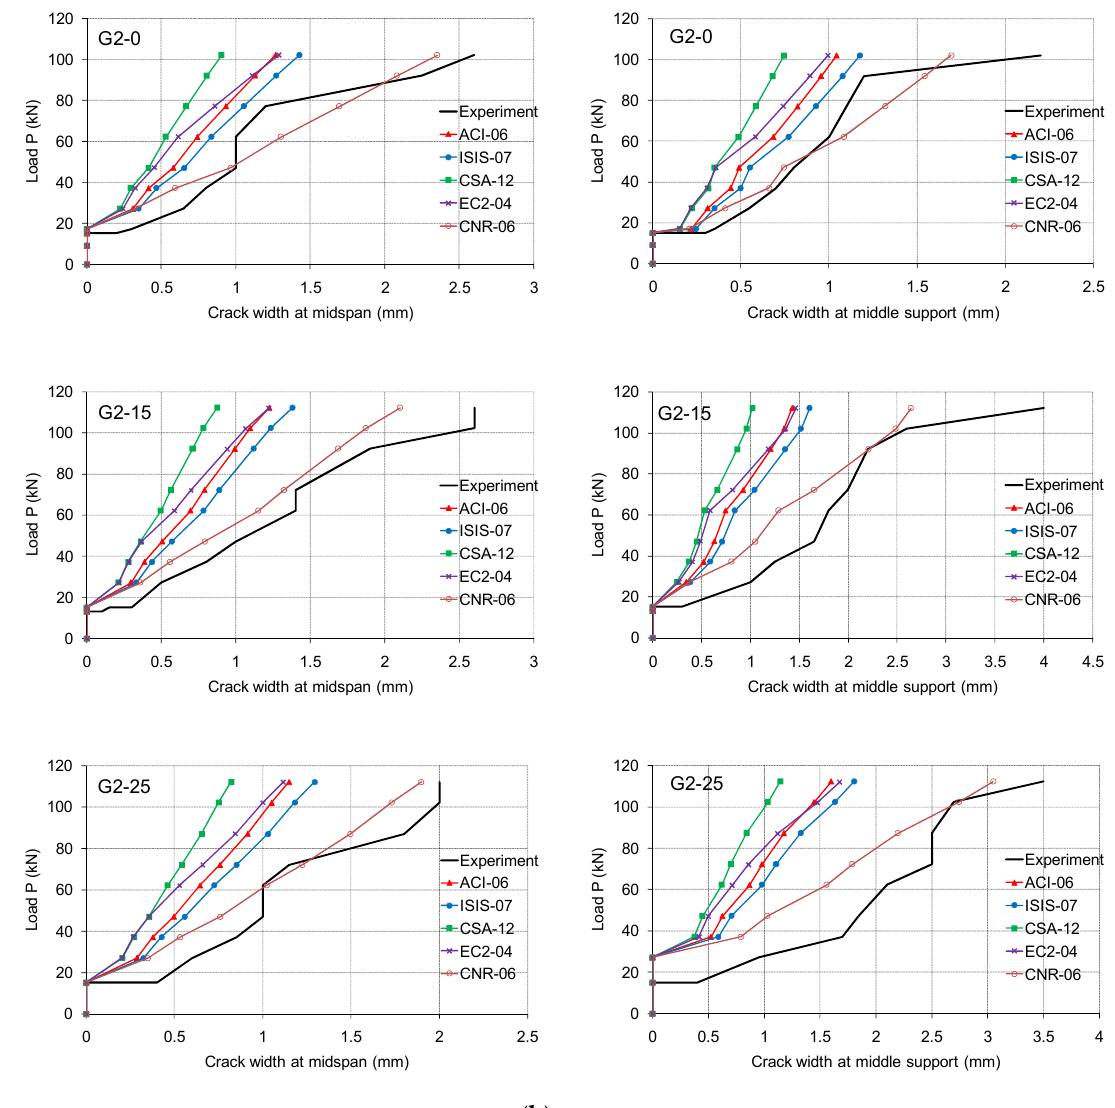
Figure 9. ( a ) Experimental and predicted load–crack width relationships for tested beams series 1. ( b ) Experimental and predicted load–crack width relationships for tested beams series 2.